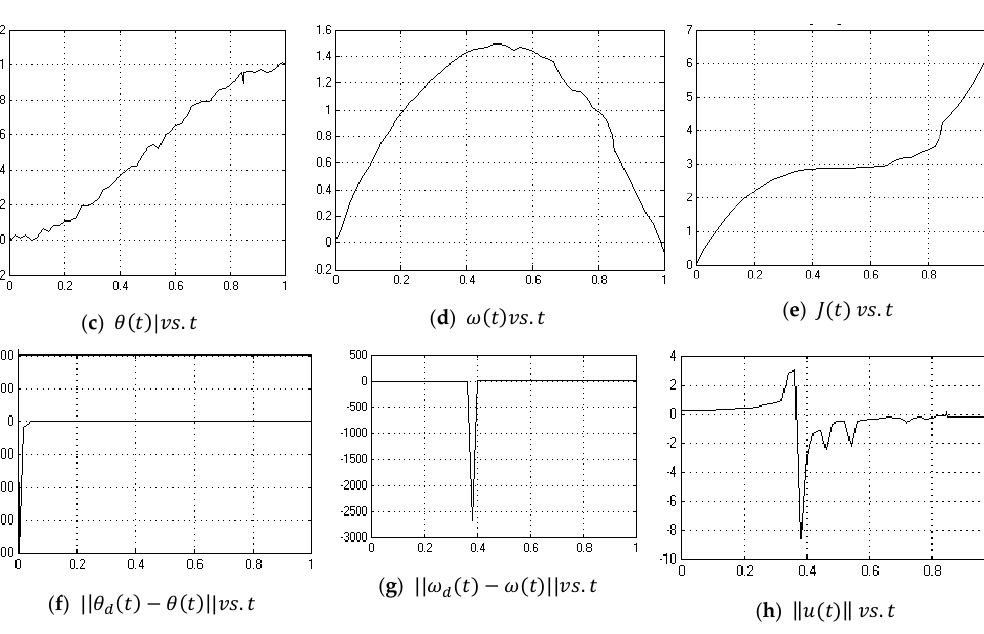
Figure A6. Continuous predictive optimum controlled simulation model with noise.